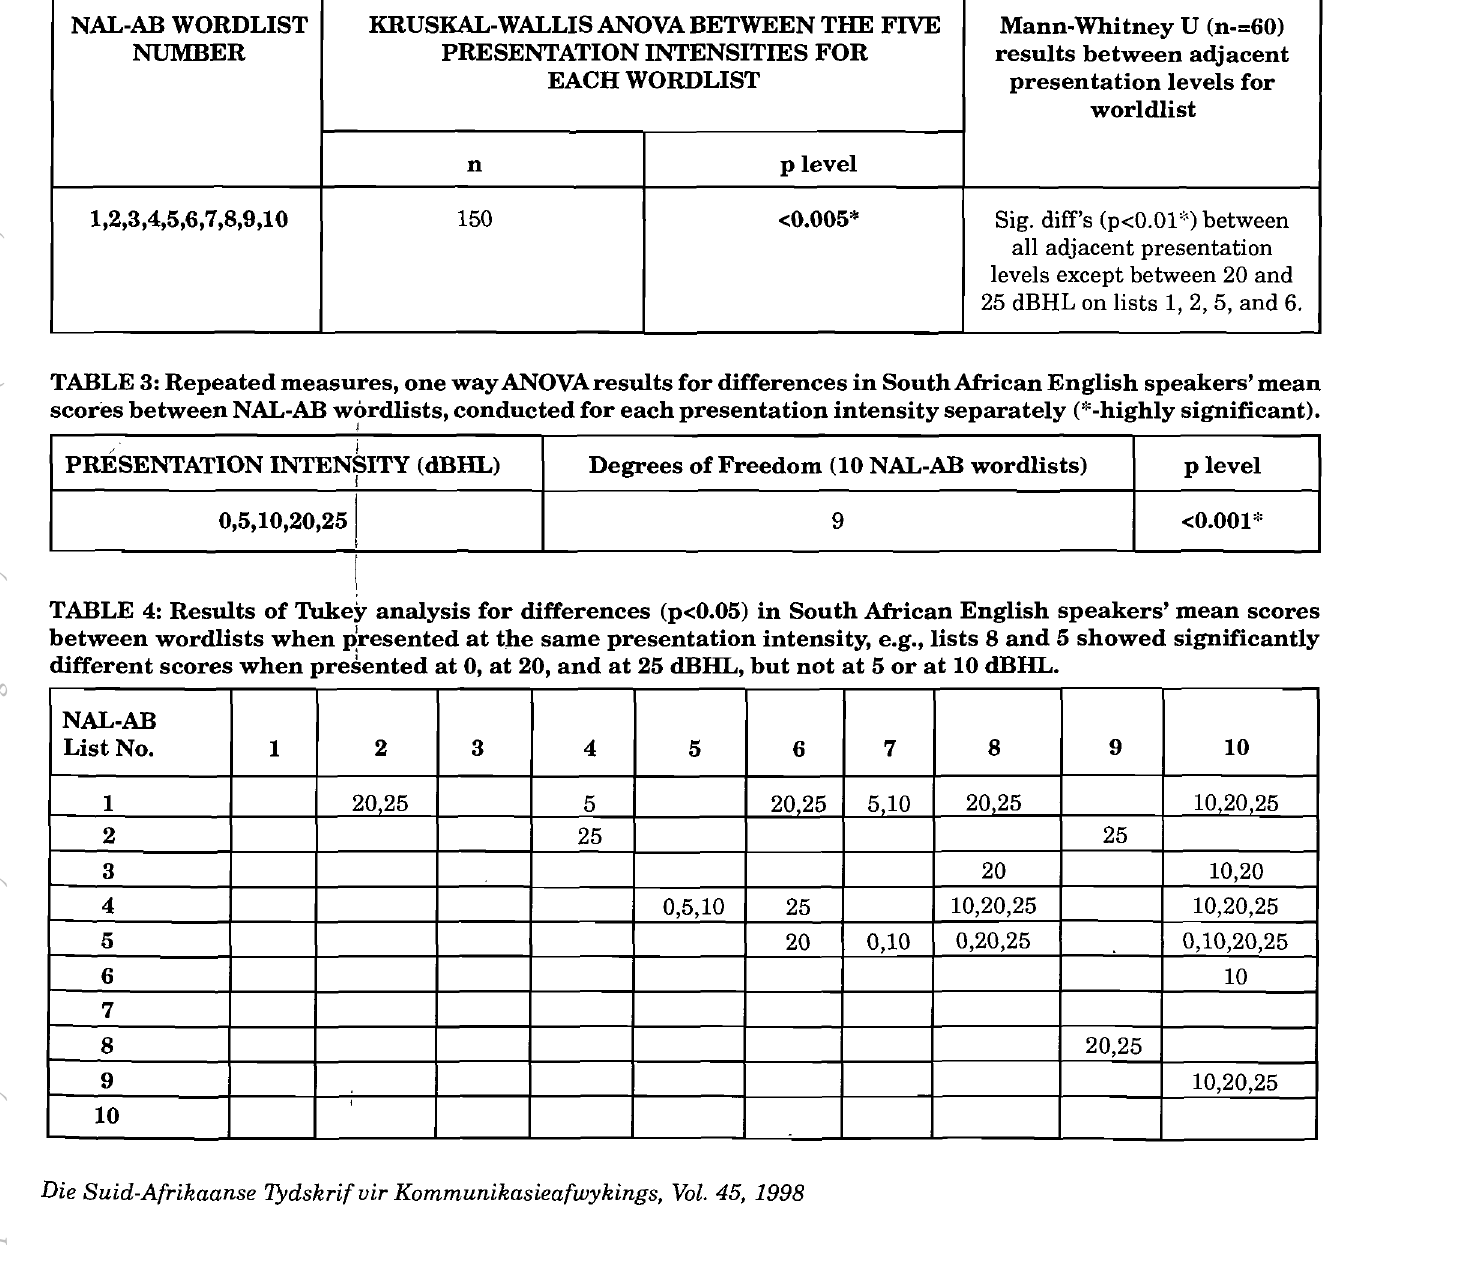
TABLE 2: Kruskal-WallisANOVA by Ranks and Mann-Whitney U results for differences in South Mrican English speakers' mean scores between presentation intensities, conducted for each NAL-AB wordlist separately (* highly significant).